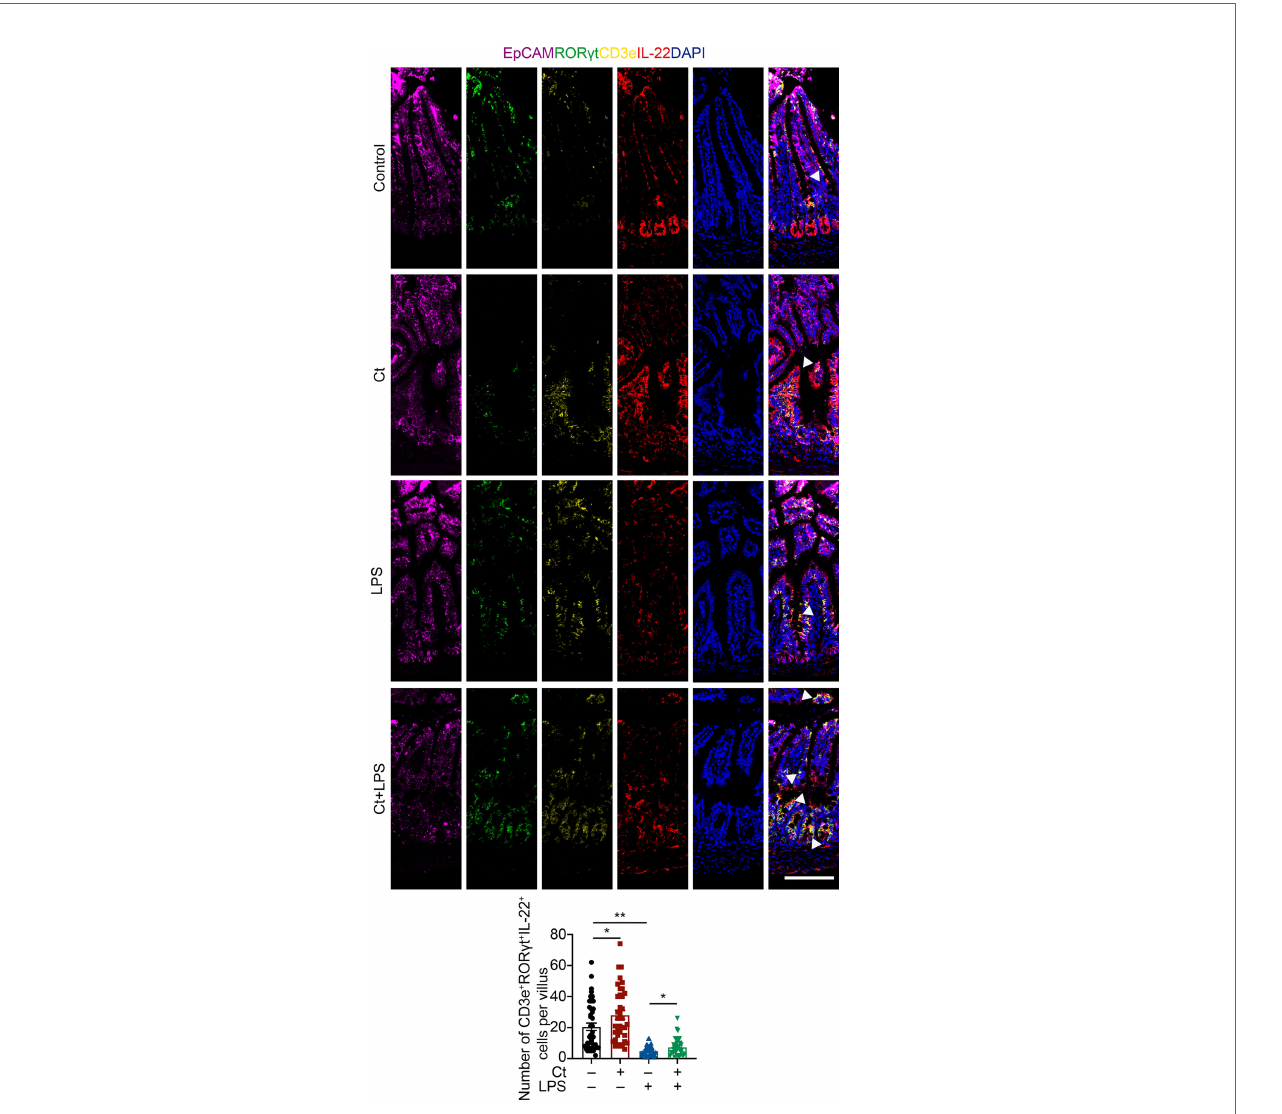
FIGURE 7 | Ct stimulates intestinal Th17 cells to enhance the production of IL-22 in the ileum. Ileal slices were stained with EpCAM (violet), ROR g t (green), CD3e (yellow), IL-22 (red), and DAPI (blue). The samples were from the continuous slices in Fig. 6. White triangle: localization. Scale bar: 100 m m. Data were presented as mean ± SEM. The signi fi cant difference was analyzed by two-way unpaired t-tests. * P < 0.05, ** P <